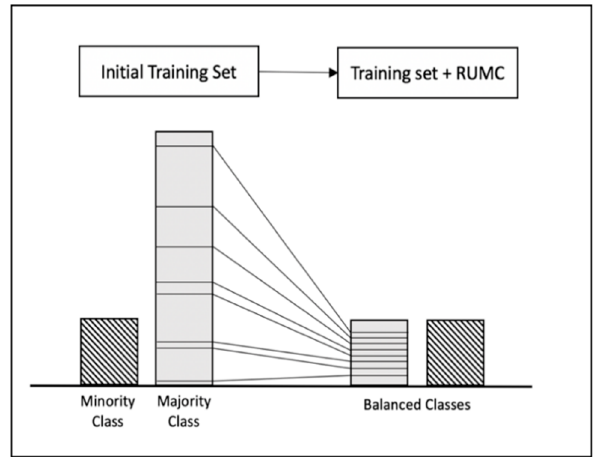
Figure 4. Random undersampling of the majority class.